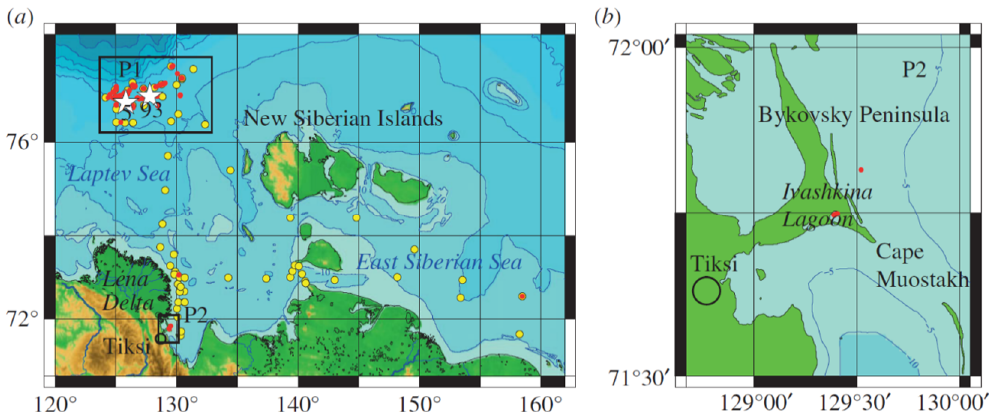
Figure 5. Study area. ( a ) Black rectangles mark the position of polygon 1 (P1, outer shelf) and polygon 2 (P2, near shore area); red circles show the position of discovered seep fields in the study area where hydro acoustical investigations were performed: white stars mark the position of two seep fields (F5 and F93) where detailed surveys were performed; yellow circles show the position of oceanographic stations in the study area; green shows land; blue shows water; bathymetry lines are shown as black counters; ( b ) the red circle shows position of the Ivashkina Lagoon within P2 [12].